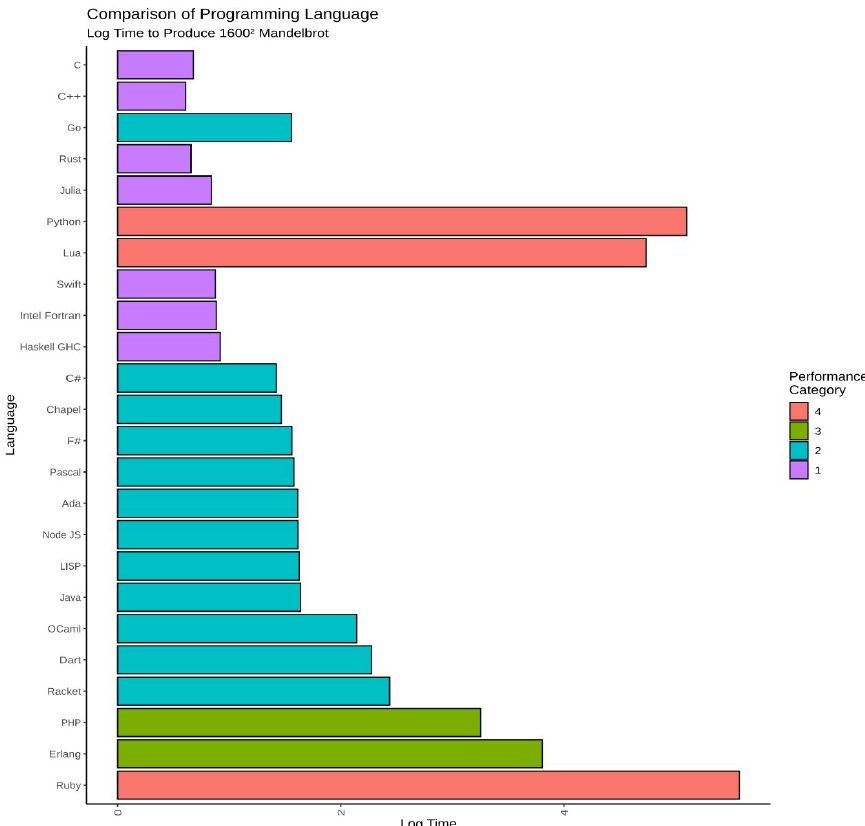
Fig. 5. Programming language performance diagram